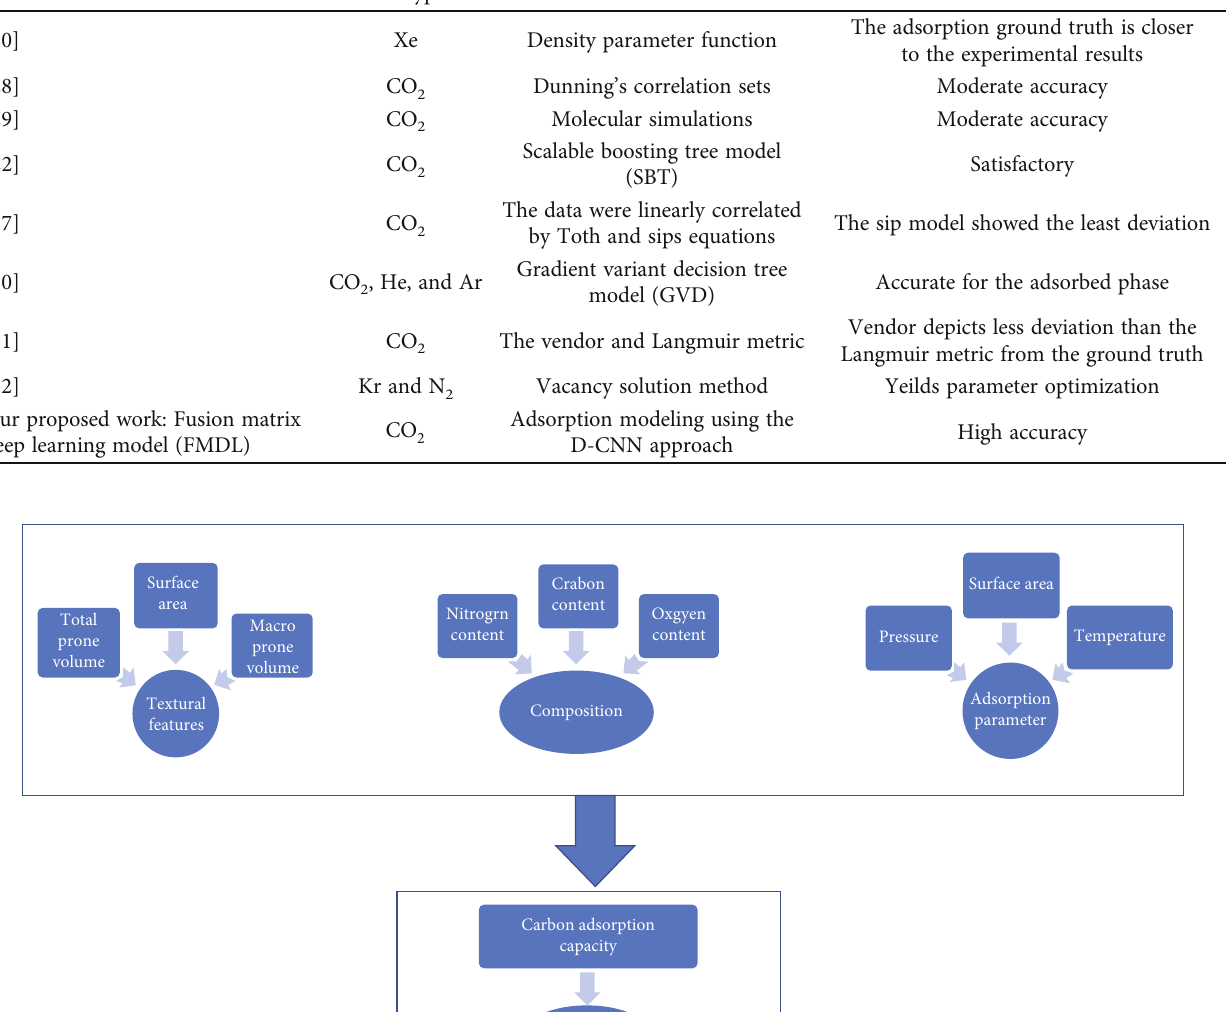
Table 1: Summary of gas adsorption simulation deep learning prediction models for di ff erent gases using density, molecular, and vacancy volume.